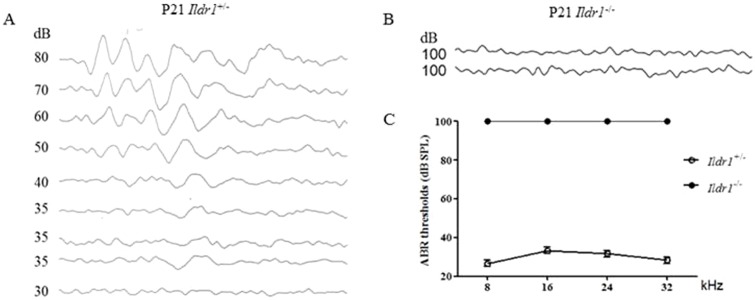
Auditory dysfunction in Ildr1−/− mouse.Offspring at P21 derived from Ildr1+/− × Ildr1−/− mating were subjected to auditory-evoked brainstem response (ABR) testing. (A,B) ABR response to tone bursts at a representative frequency of 8 kHz in P21 Ildr1+/− mouse (A) and P21 Ildr1−/− mouse (B). (C) The average click sound pressure level (SPL) threshold of Ildr1+/− and Ildr1−/− mice at P21. Ildr1+/− mice showed normal SPL thresholds at all frequencies measured, but Ildr1−/− mice showed no waveforms at intensities up to 100 dB SPL at P21 (n = 4 mice for each time point).